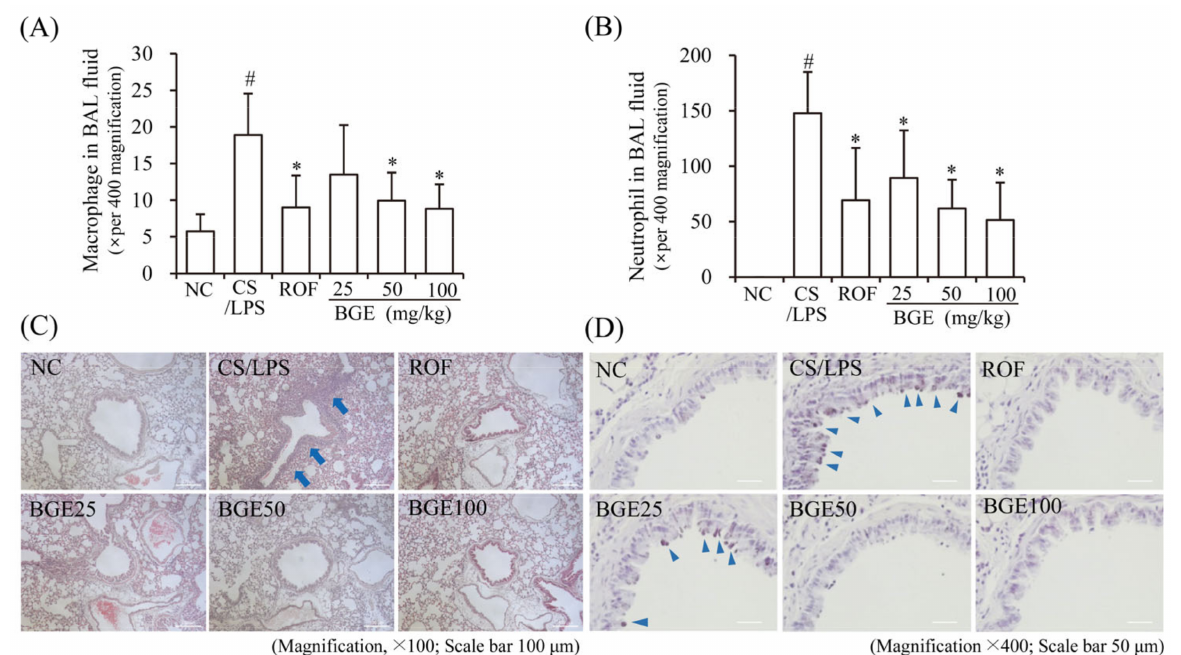
Figure 2. Effects of the BGE on the recruitment of inflammatory cells and secretion of mucus in the airway of the CS/LPS-treated mice model. ( A , B ) Cells were isolated from BAL fluids and stained with Diff-Quik reagent. The values are expressed as means ± standard deviation (SD) ( n = 6). # p < 0.01: significantly different compared with NC; * p < 0.05: significantly different compared with CS/LPS -induced group. ( C ) Hematoxylin and eosin (H&E) staining was performed to assess the accumulation of inflammatory cells around the peribronchial region. Blue arrows indicate regions where inflammatory cells are concentrated. Magnification, 100 × , scale bar, 100 µ m. ( D ) Mucus secretion level in the lung tissue was determined using periodic acid-Schiff (PAS) staining. Blue arrowheads indicate mucus. Magnification, 400 × , scale bar, 50 µ m. ROF was used as a positive control. NC: normal control mice; CS/LPS: CS/LPS-exposed mice; ROF: 5 mg/kg ROF-treated CS/LPS mice; BGE 25: 25 mg/kg BGE-treated CS/LPS mice; BGE 50: 50 mg/kg BGE-treated CS/LPS mice; and BGE 100: 100 mg/kg BGE-treated CS/LPS mice group. Representative images were randomly selected from among 3 to 4